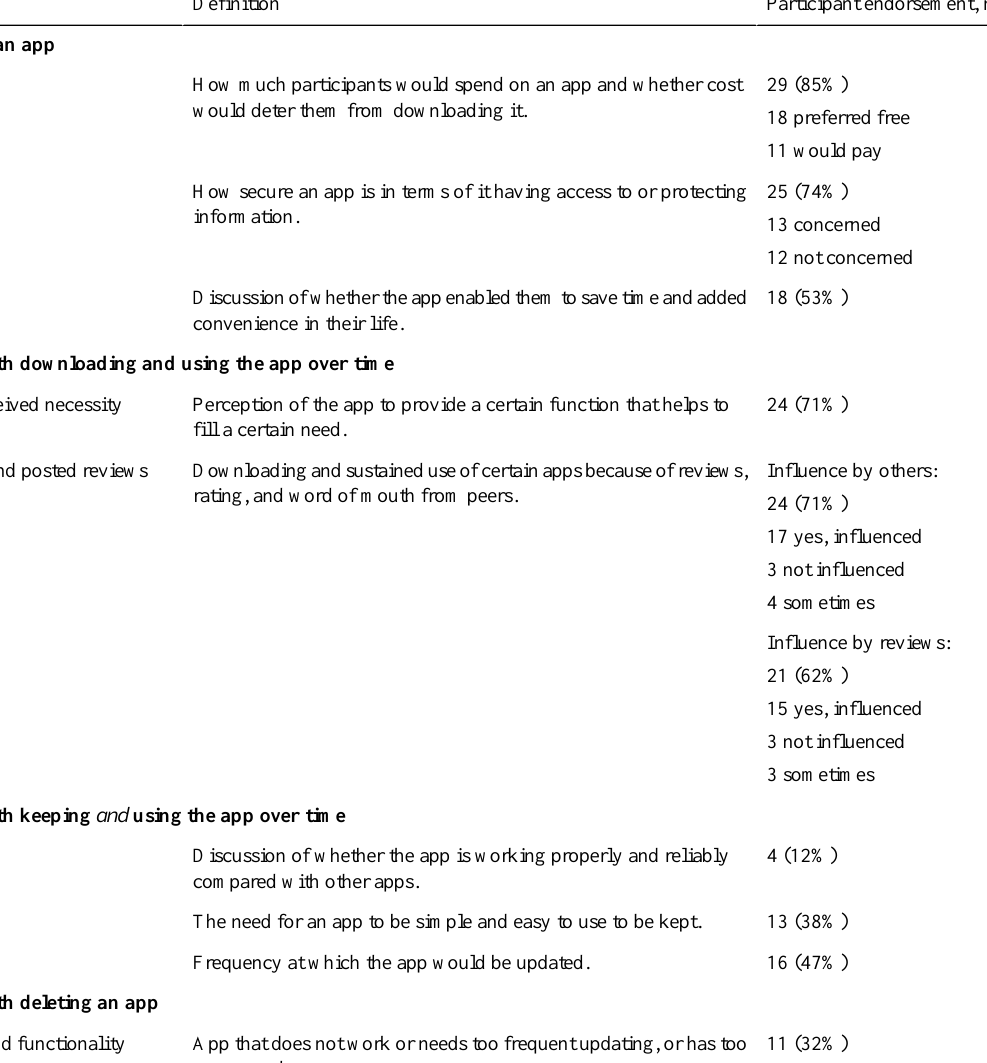
Table 2. Themes, definitions, and participant endorsements of reasons to download, continue to use, and delete apps (N=34). Reasons to download an app